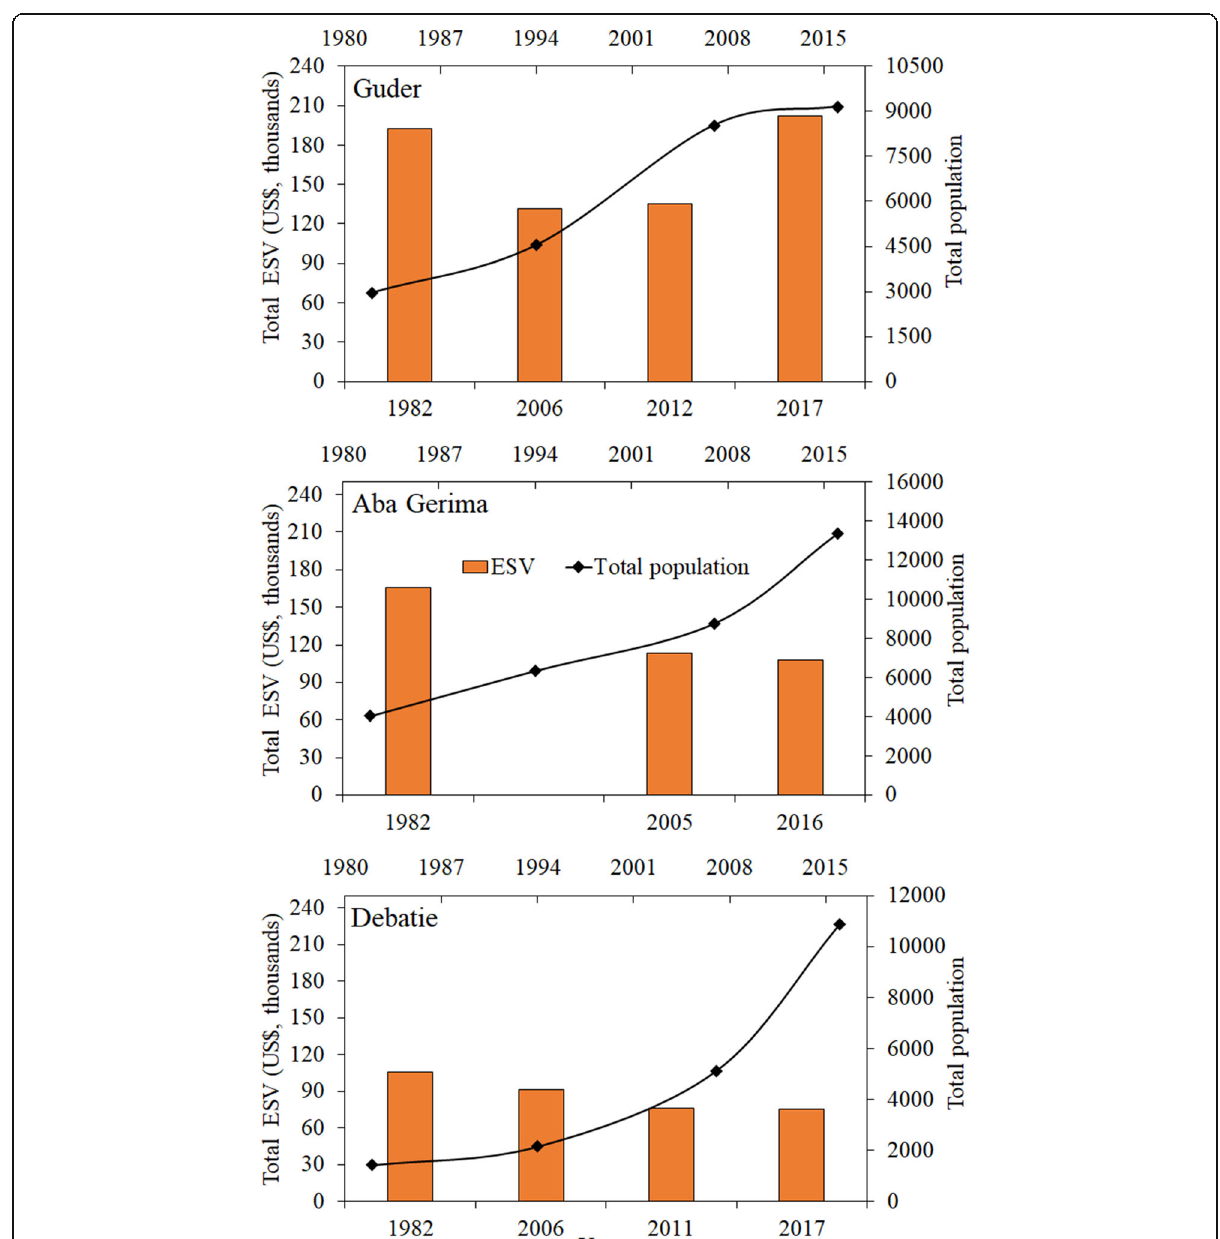
Fig. 4 Relationship between total ecosystem service value (ESV) and population size from 1982 to 2017 in Guder, Aba Gerima, and Debatie watersheds,